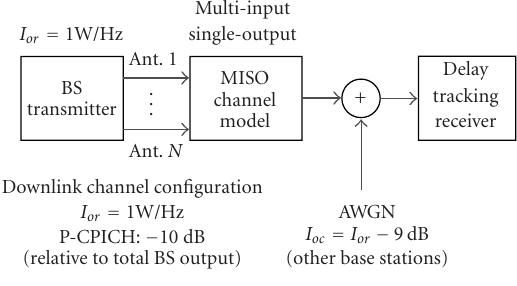
Figure 6: End-to-end simulation